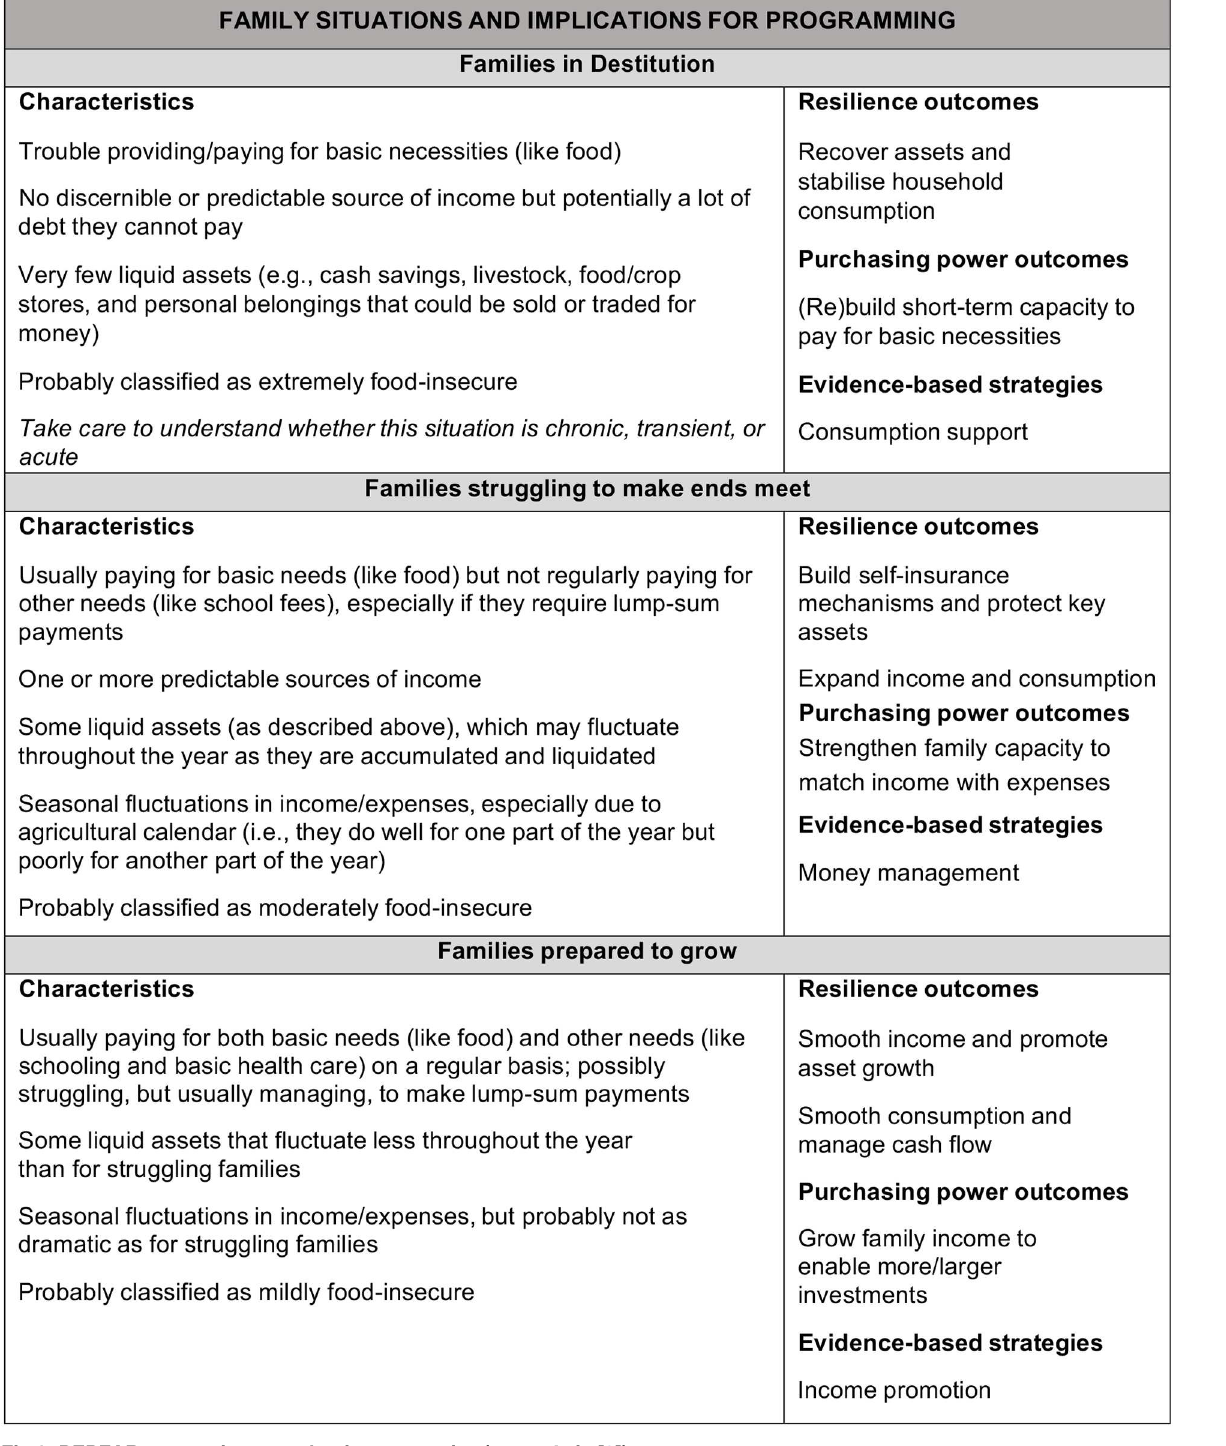
PLOS ONE | DOI:10.1371/journal.pone.0163285 September 21,